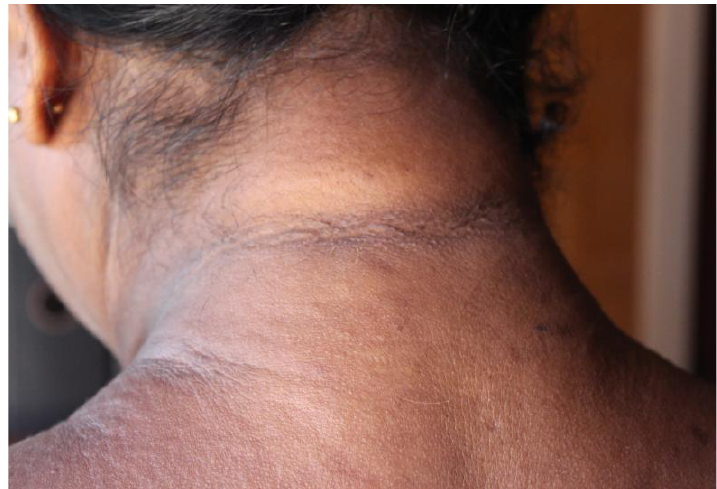
Figure 1. Figure illustrate the waxy indurated thicken skin in the neck and upper back